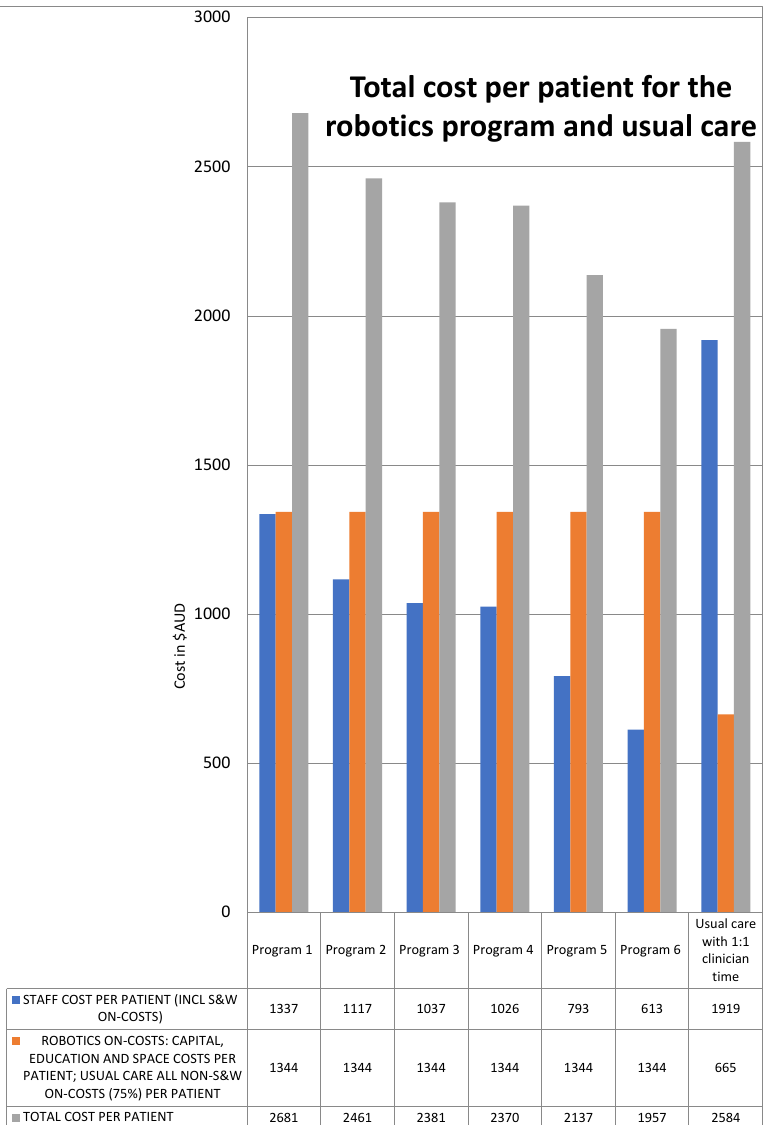
Figure 4. Total cost per patient.